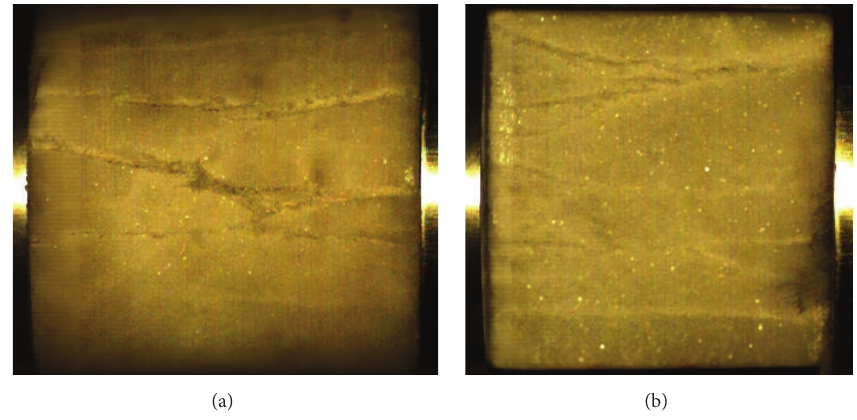
Figure 9: Typical failure mode of cylindrical and prismatic specimens in SHPB test: (a) cylindrical specimen C3 and (b) prismatic specimen R3 (impact loading direction: from right to left).